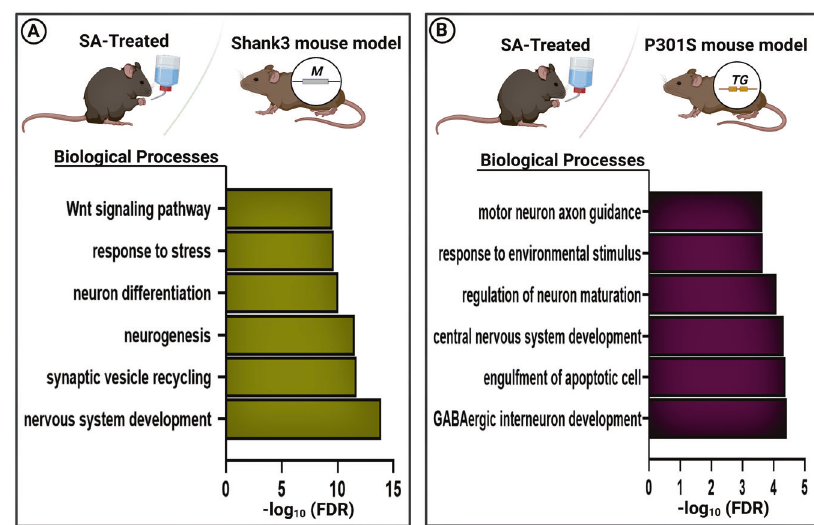
Fig. 5 Comparative analysis between SA-treated mice and ASD/AD mouse models. BP analysis was conducted on the shared cortical SNO proteins between A) SA-treated group and the Shank3 mutant group; B) SA-treated group and P301S mutant group. * Bars represent the – log10 of the Benjamini corrected false discovery rate